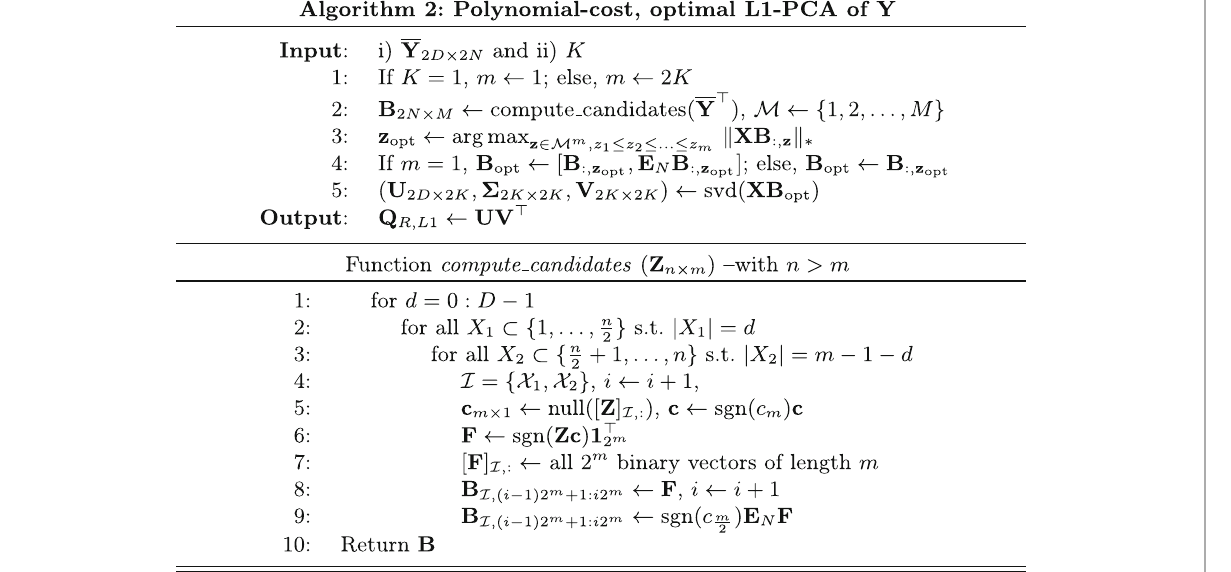
and updates L ( t + 1 ) to L ( t ) \ { ( k − 1 ) 2 N + n } . If, otherwise, (cid:15) (cid:15)